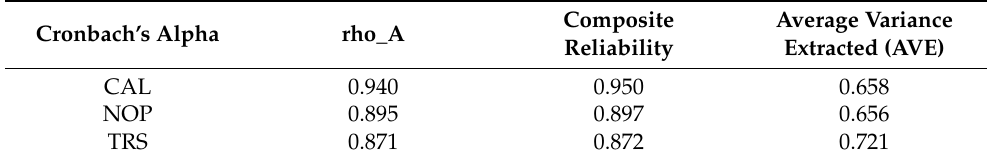
Table 3. Construct reliability and validity of the Quality Management Education scale (QMES).